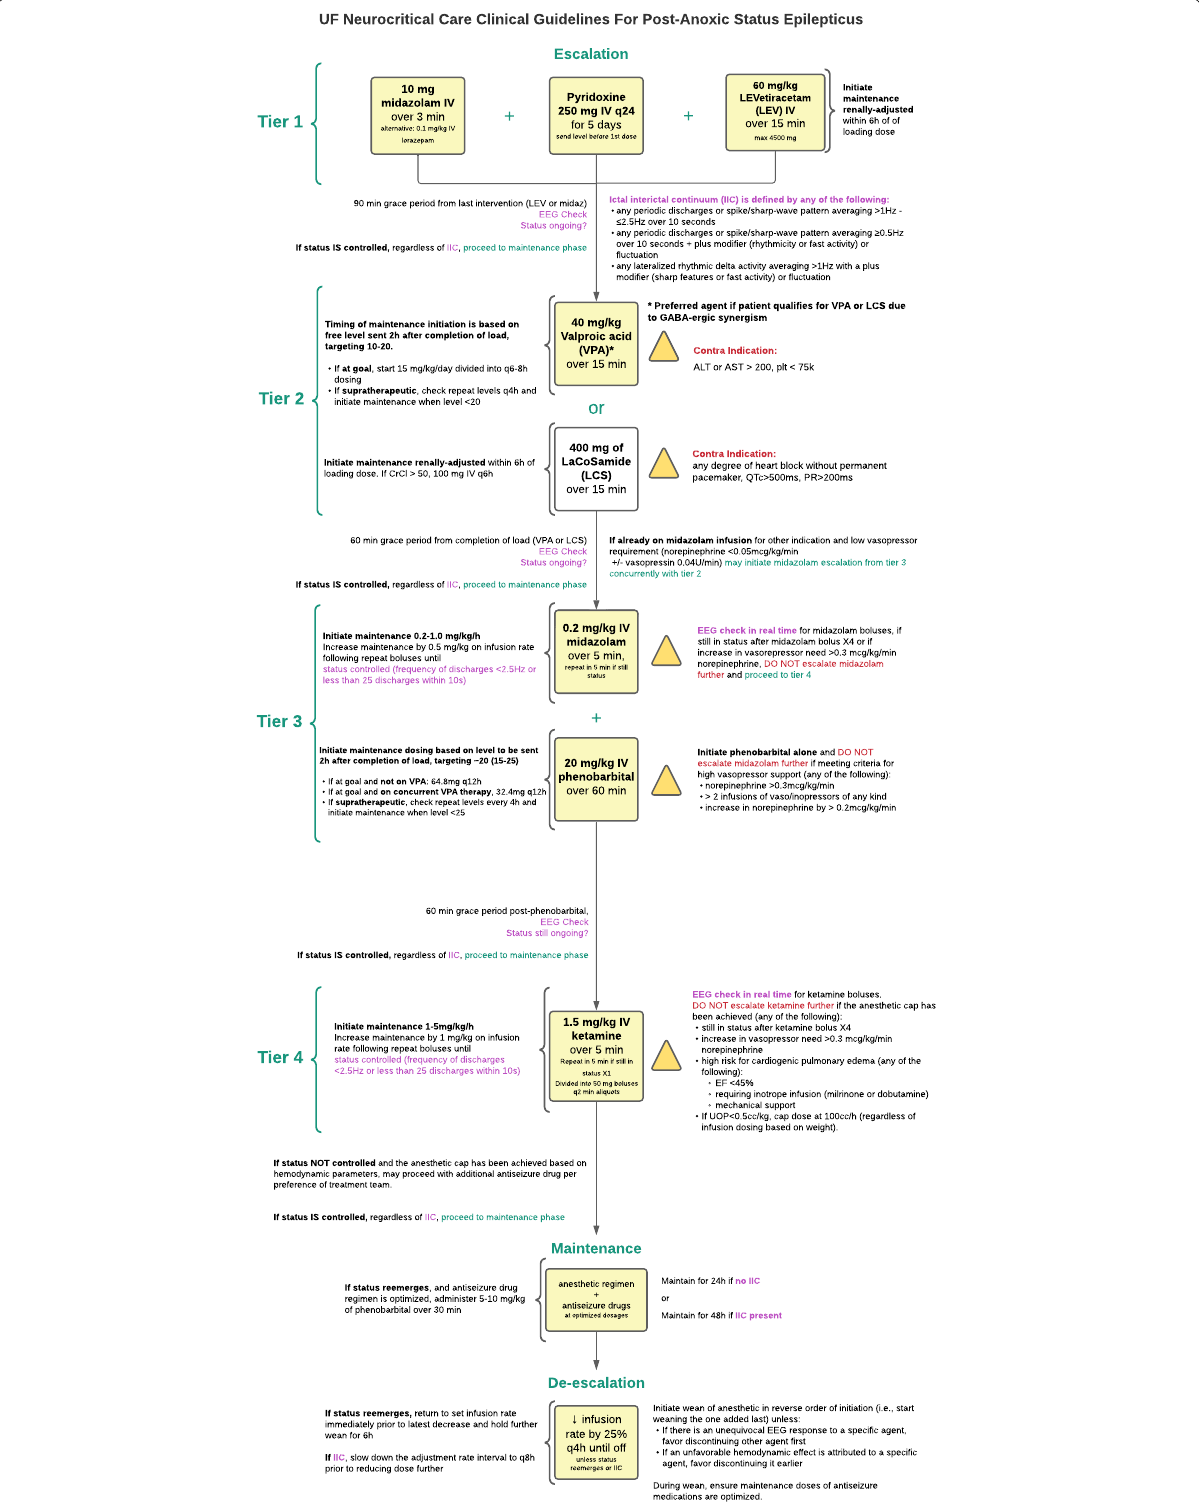
Fig. 2 University of Florida neurocritical care guidelines for post-anoxic status